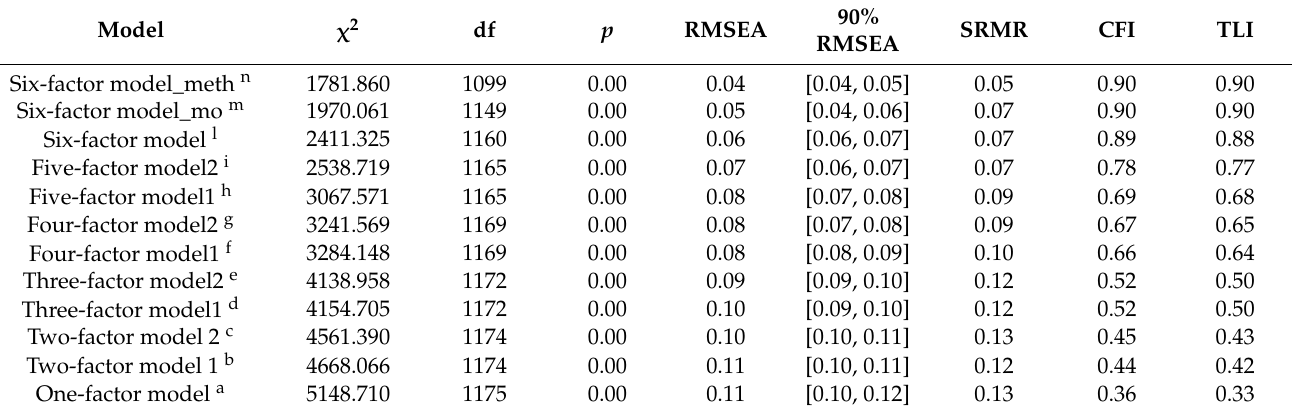
Table 2. Fit indices for the six-factor model and the alternative models ( n =